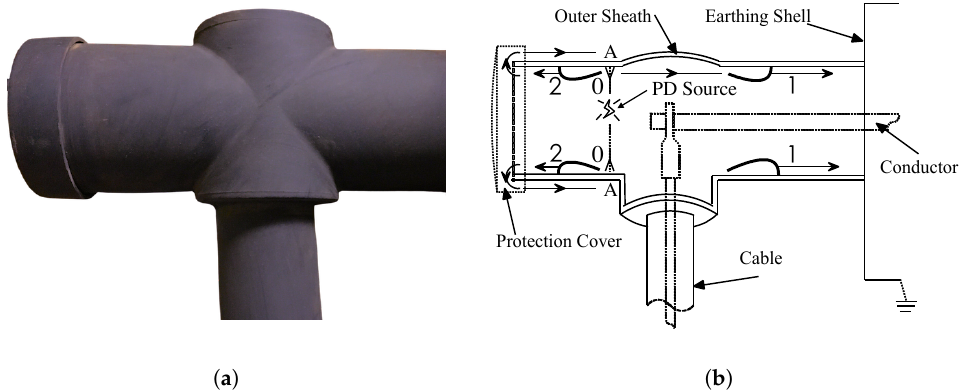
Figure 2. Photograph of a cable termination and corresponding schematic diagram of EM wave propagation path on the cable termination surface. ( a ) Photograph of a 35 kV/600 A elbow cable termination. ( b ) EM wave propagation path on the inner and outer surface of the cable